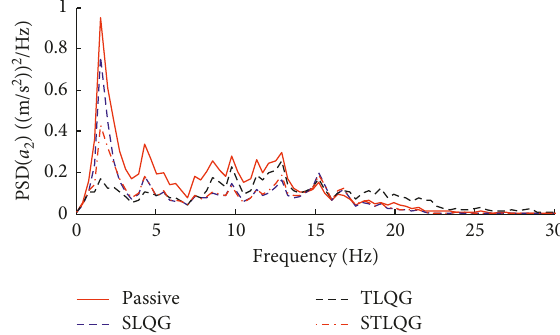
Figure 10: J - t curves under 20ms time delay.